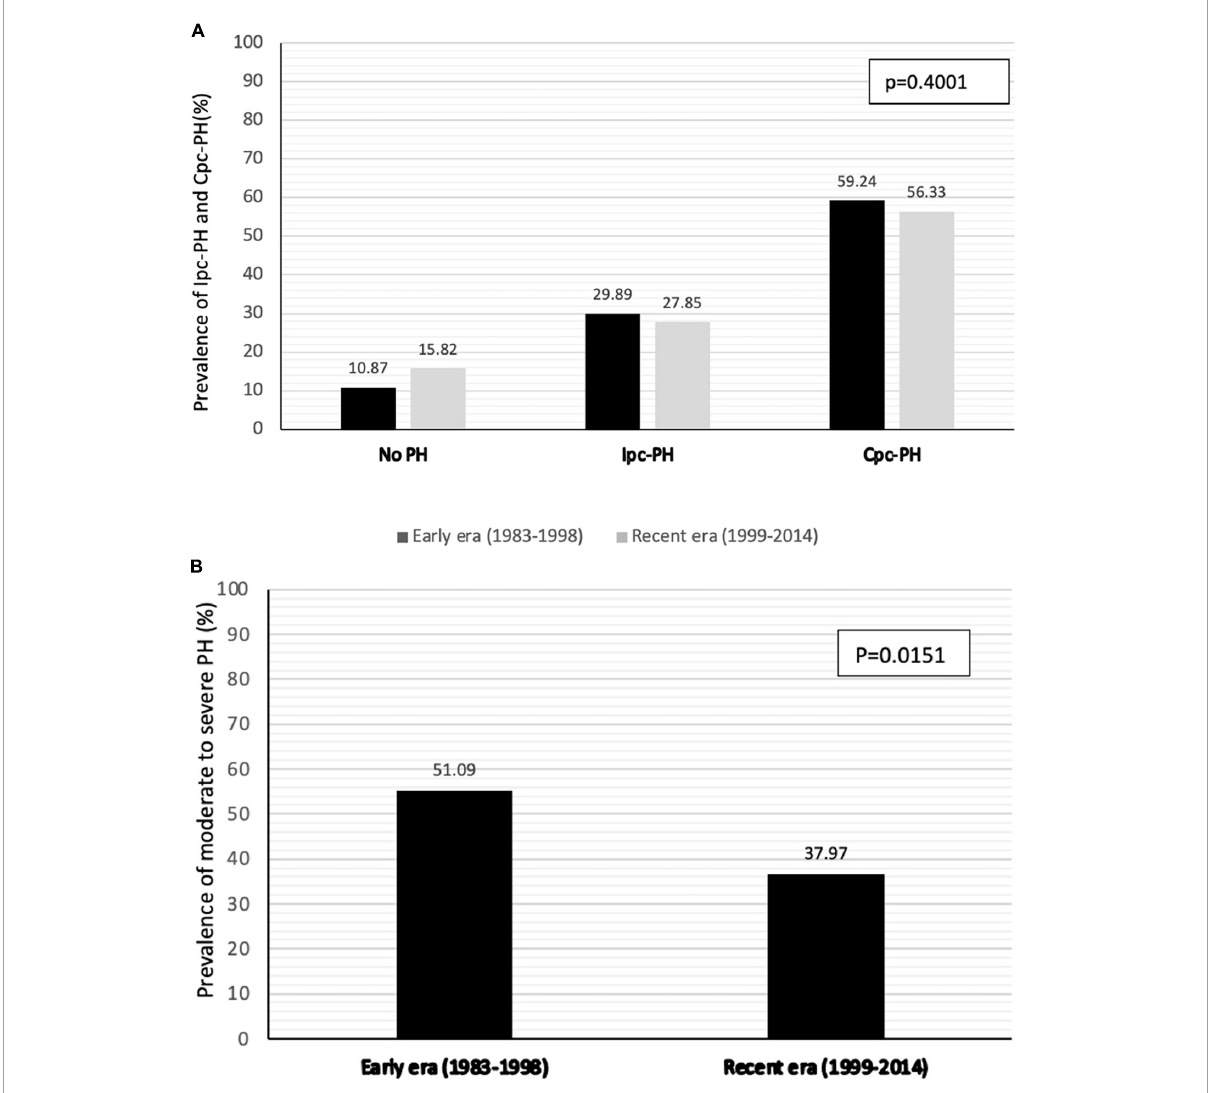
FIGURE1 Prevalence of PH and pre-capillary component (A) and prevalence of moderate to severe PH (mPAP > 35mmHg) (B) according to era of